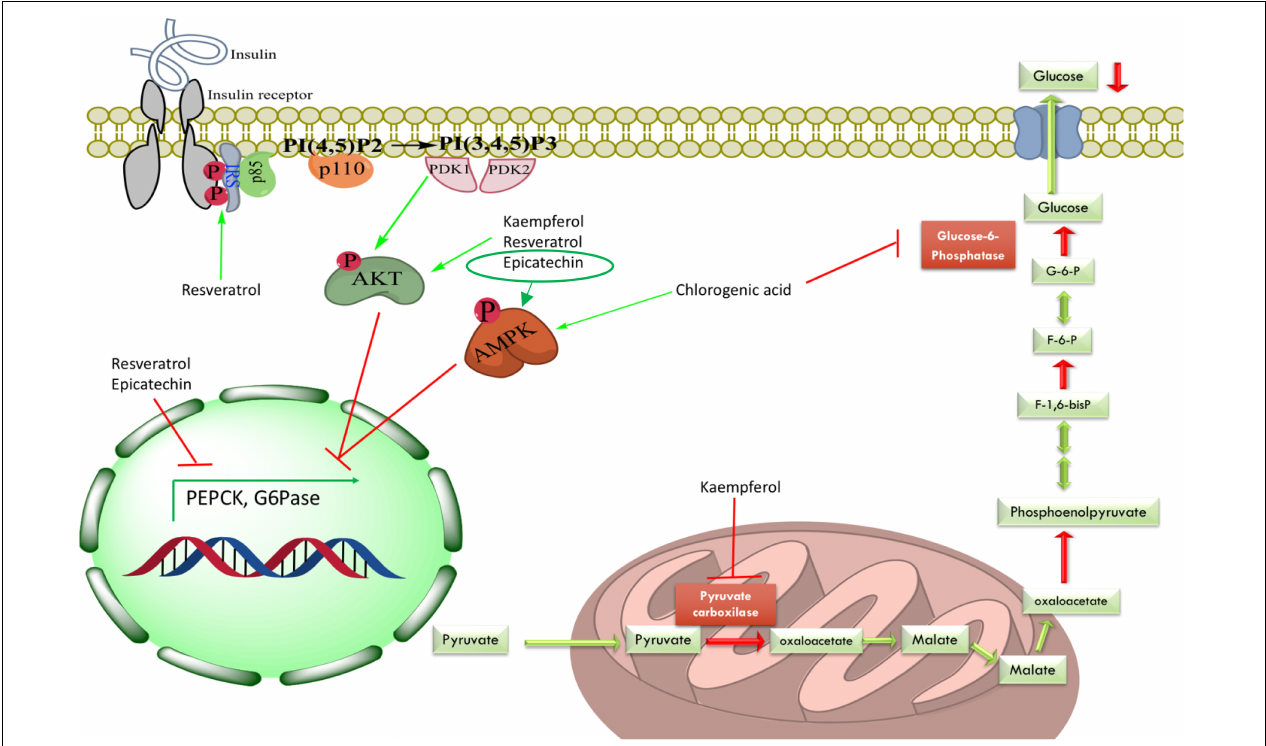
FIGURE 3 | Mechanisms of hepatic gluconeogenesis inhibition exerted by some identified compounds from evaluated plant extracts in this study. Active compounds could have two main ways to decrease HGO: (1) direct inhibition of gluconeogenic enzymes, for instance, inhibition of G6Pase system by CA and inhibition of PC by kaempferol; or (2) decreasing expression levels of gluconeogenic enzymes via Akt pathway (kaempferol, resveratrol and, epicatechin) or AMPK activation (CA and epicatechin). IRS, insulin receptor substrate; PI(4,5)P2, phosphatidylinositol 4,5-bisphosphate; PI(3,4,5)P3, phosphatidylinositol 3,4,5-triphosphate; PDK1, phosphoinositide-dependent kinase 1; PDK2, phosphoinositide-dependent kinase 2; Akt, protein kinase B; AMPK, AMP-activated protein kinase; G6P, glucose-6-phosphate; F-6-P, fructose-6-phosphate; F-1,6-bisP, fructose-1,6-bisphosphate; G6Pase,